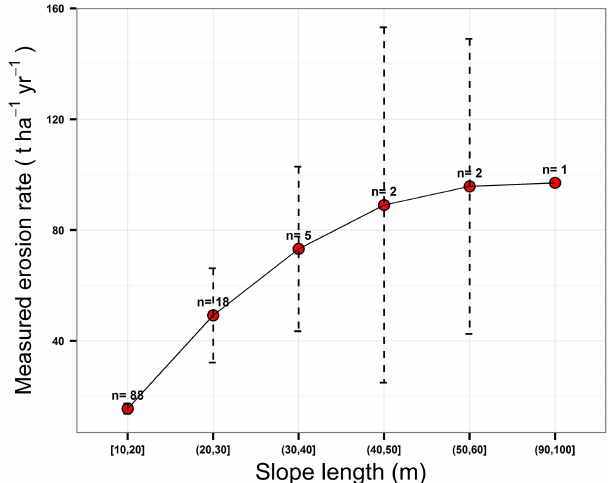
Figure 3. Topsoil erosion rate (weighted mean and standard devi- ation) vs. slope length for erosion plots under arable land on the